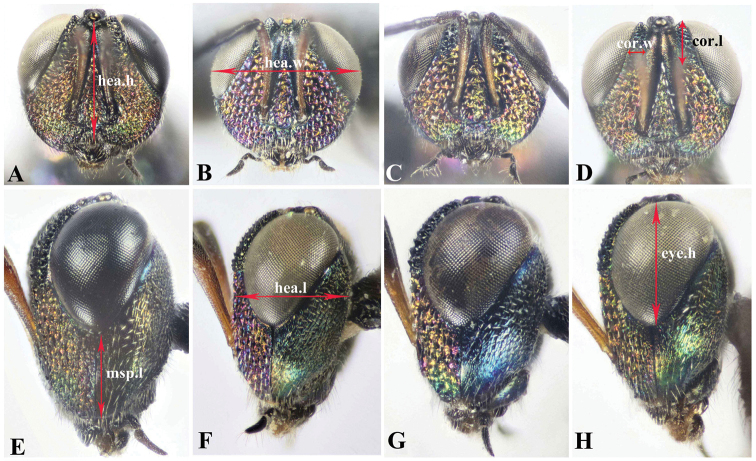
Frontal and lateral view of head, Holotype A,EOodera
arabica sp. nov. B,FOodera
omanensis sp. nov. C,GOodera
rapuzzii sp. nov. D,HOodera
similis sp. nov.